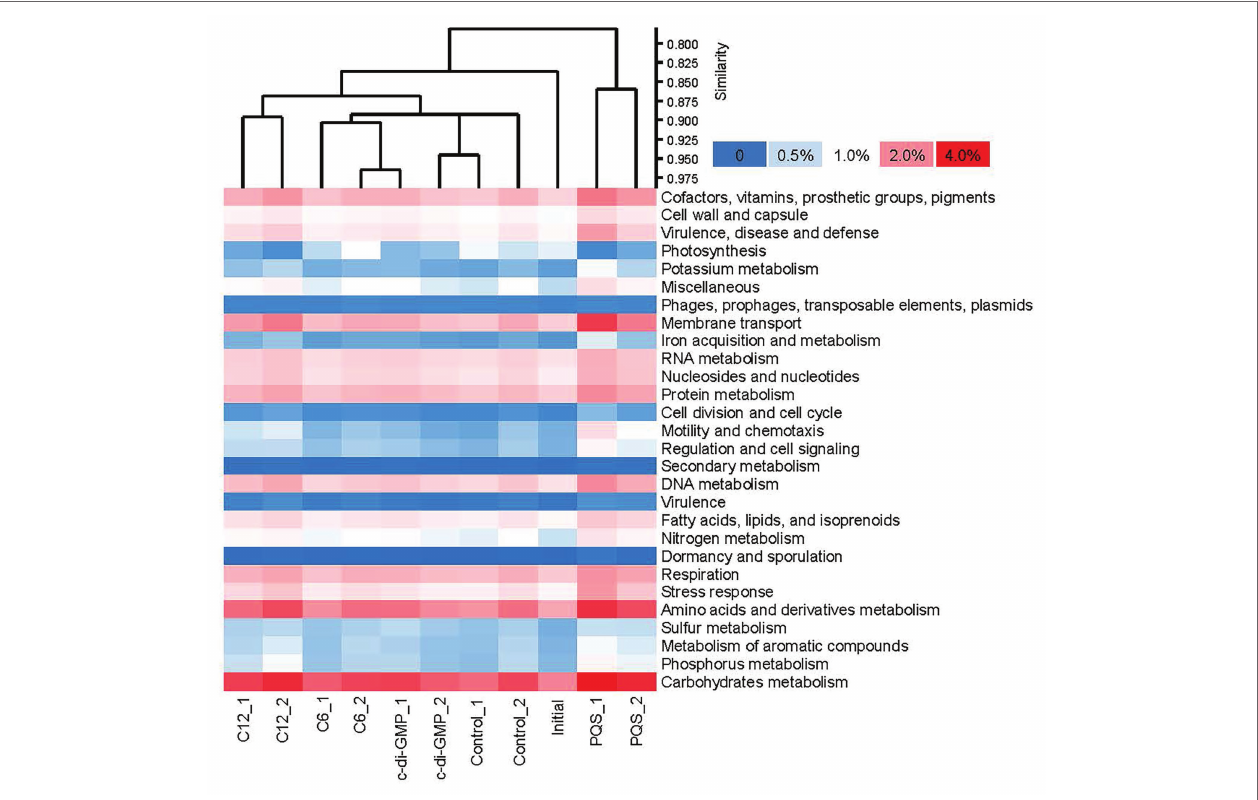
FIGURE 2 | Functional profiles (SEED level 1) of the multi-species biofilms in the signal molecules treatment experiment. The profiles were generated by searching the metagenomic reads against the eggNOG database and by classifying the functions according to the SEED category, and the relative abundance of each category was counted. Cluster analysis revealed that the Pseudomonas quinolone signal (PQS)-treated biofilms had the least similarity with the control and initial